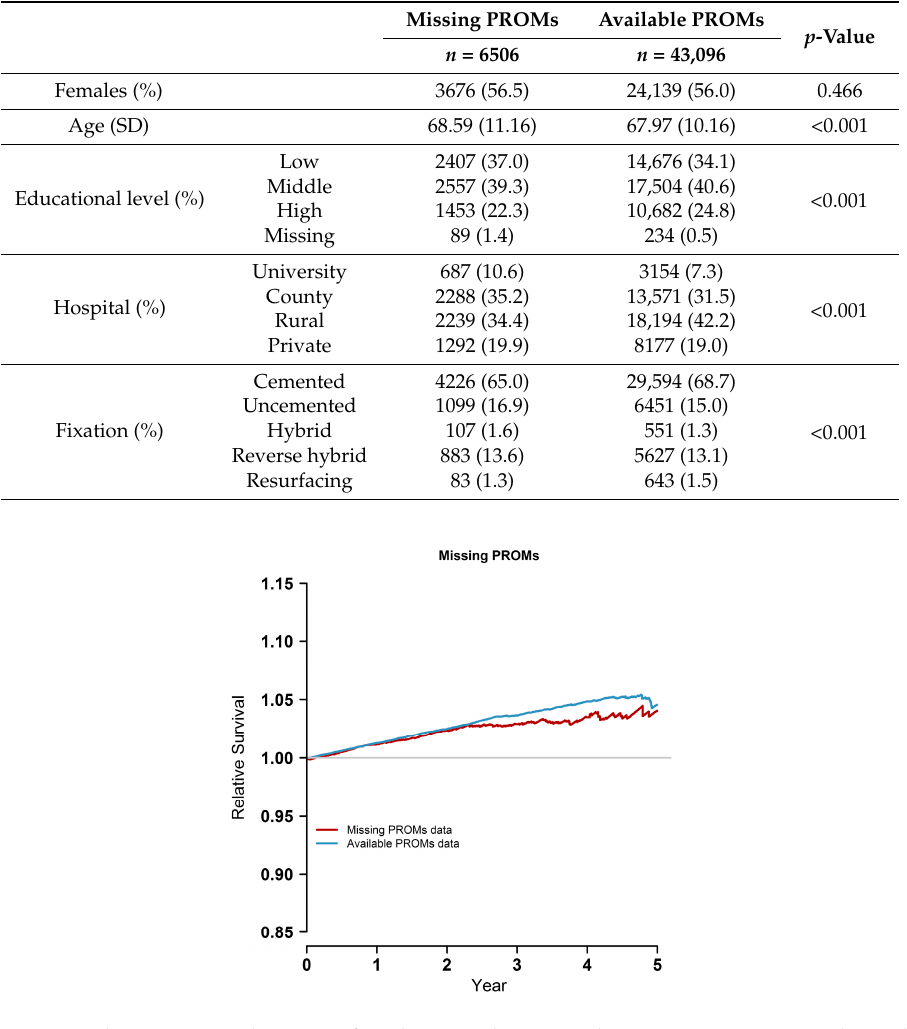
Table 3. Demographics, socioeconomics, and surgery-related data of 43,096 total hip replacement patients with PROMs data, and the 6506 total hip replacement patients without PROMs data. The data is summarized as absolute numbers and percentages for discrete variables, and means and standard deviations for continuous variables.